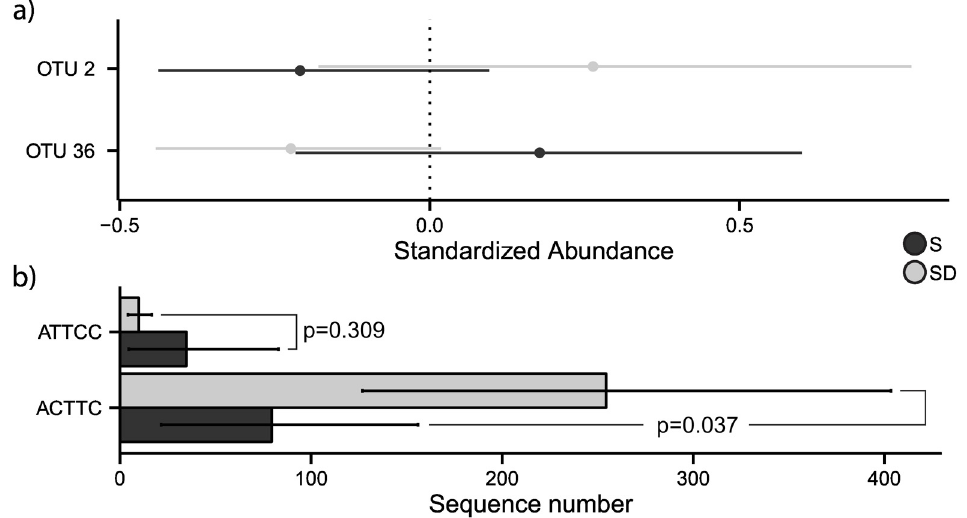
Fig 3. Differences in microbial community distribution between stable and severe decliner groups. Bacterial taxonomic profiling revealed differences between stable and severe decliner communities. a) Standardized abundances of two OTUs (OTU 2 and 36) showing a different distribution between patient groups. b) Differences between the two most represented oligotypes identified for OTU 2. Standardize abundances were calculated as: [x - mean(x)]/sd(x), where "sd" is the standard deviation and “ mean ” is the mean value. As a result, all OTUs have equal means and standard deviations (0 and 1, respectively) but different ranges. Reported p values were obtained with a Wilcoxon signed-rank test.